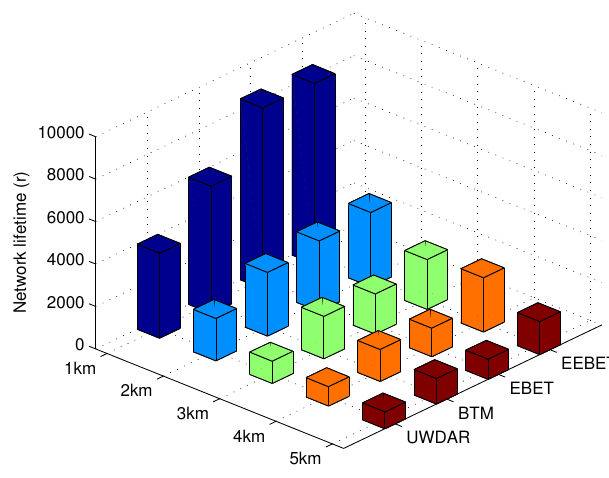
Figure 8. Comparison of network lifetime at different network radii.